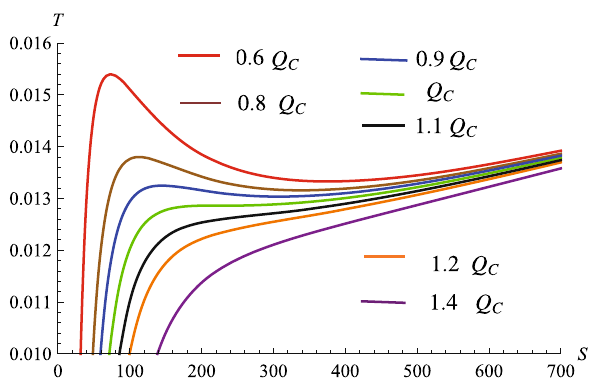
Fig. 1 The relationship between temperature T versus the entropy S for varying Q for the case α = 1 and l = 20 for charged Gauss–Bonnet AdS black hole in four dimension